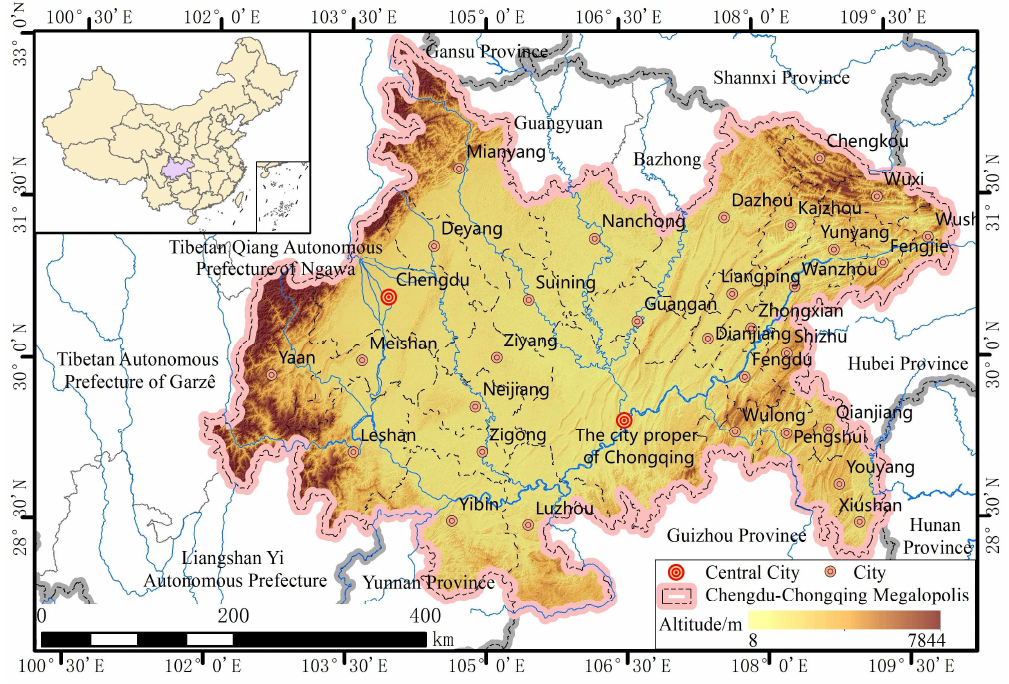
Figure 1. Map of the study area. On the map, Chengdu and Chongqing are the two central and largest cities in this megalopolis.